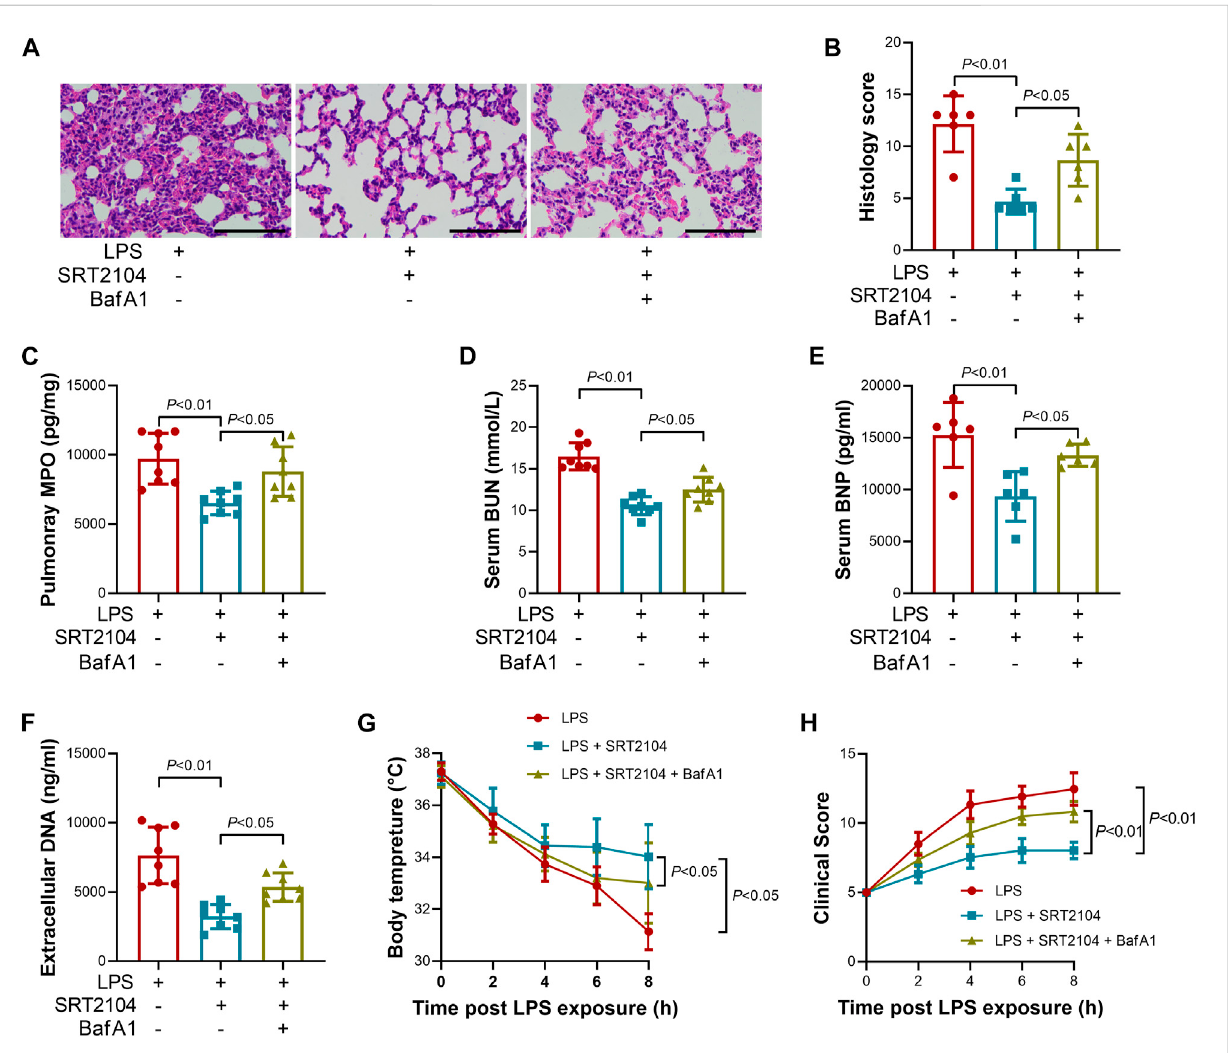
FIGURE 7 Lysosome inhibitor Ba fi lomycin A1 (BafA1) reversed the bene fi cial effects of SRT2104 on multiple organ injury. C57BL/6 mice were challenged with LPS to induce systemic in fl ammation, vehicle or SRT2104 (25 mg/kg) was injected intraperitoneally with or without BafA1 (1 mg/kg) co-administration. The mice were sacri fi ced 8 h post LPS exposure, and the lung samples as well as serum samples were collected. (A) HE staining was performed in lung tissues and the representative image of each group was shown (Scale bar: 100 μ m); (B) The histological score was calculated based on the HE- stained sections; n = 6. (C) The level of MPO in lung tissue was determined; (D,E) The serum levels of (D) BUN and (E) BNP were determined; (F) The level of extracellular DNA in serum was determined; (G) The body temperature of the experimental animals was recorded; (H) The clinical score of the experimental animals was calculated; n = 8. Data were expressed as means